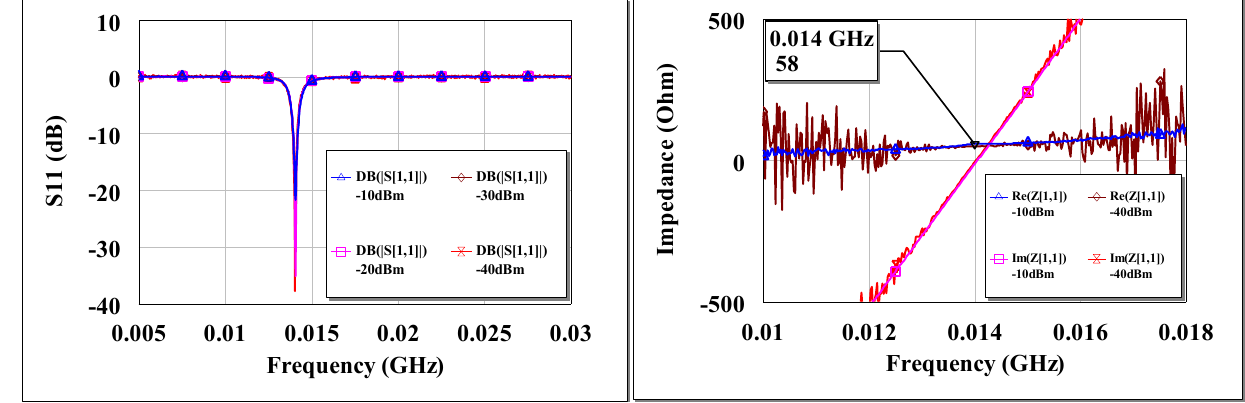
Figure 15. Measured open circuit S of the L-matched HSMS-286C diodes at 13.6 MHz 11 for different input power levels from a 50 Ω source ( left ), measured open circuit input impedance at −10 dBm and −40 dBm of the L-matched HSMS-286C diode at 13.6 MHz ( right ).